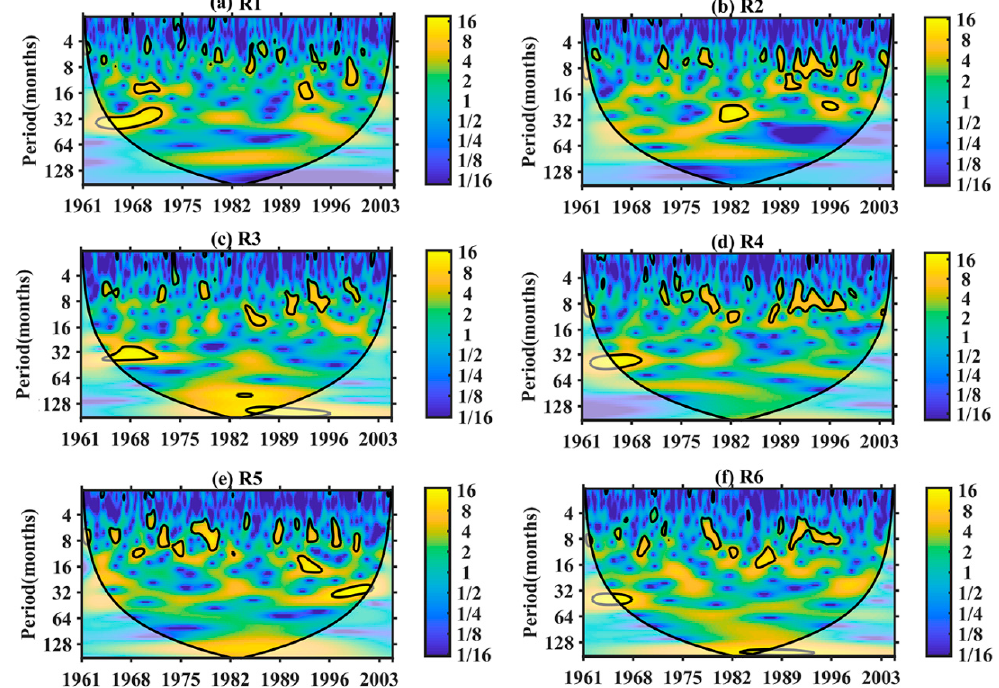
Figure 7. The power spectrum of continuous wavelet transform (CWT) of the SPI series from 1961 to 2004 for the six sub-regions. The color from blue to yellow indicates the increasing wavelet power. The black contour designates the 5% significance level against red noise and the cone of influence (COI), where the edge effects are not negligible, is shown as a light-shaded area. Table 5. Periodicity of drought variability and its link with climate indices from 1961 to 2004 in the six sub-regions.